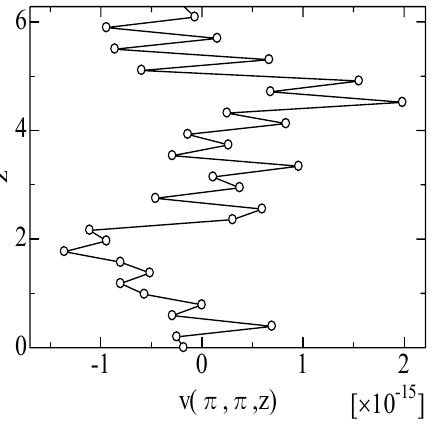
Fig. 6 Distribution of velocity v at x = ( π , π